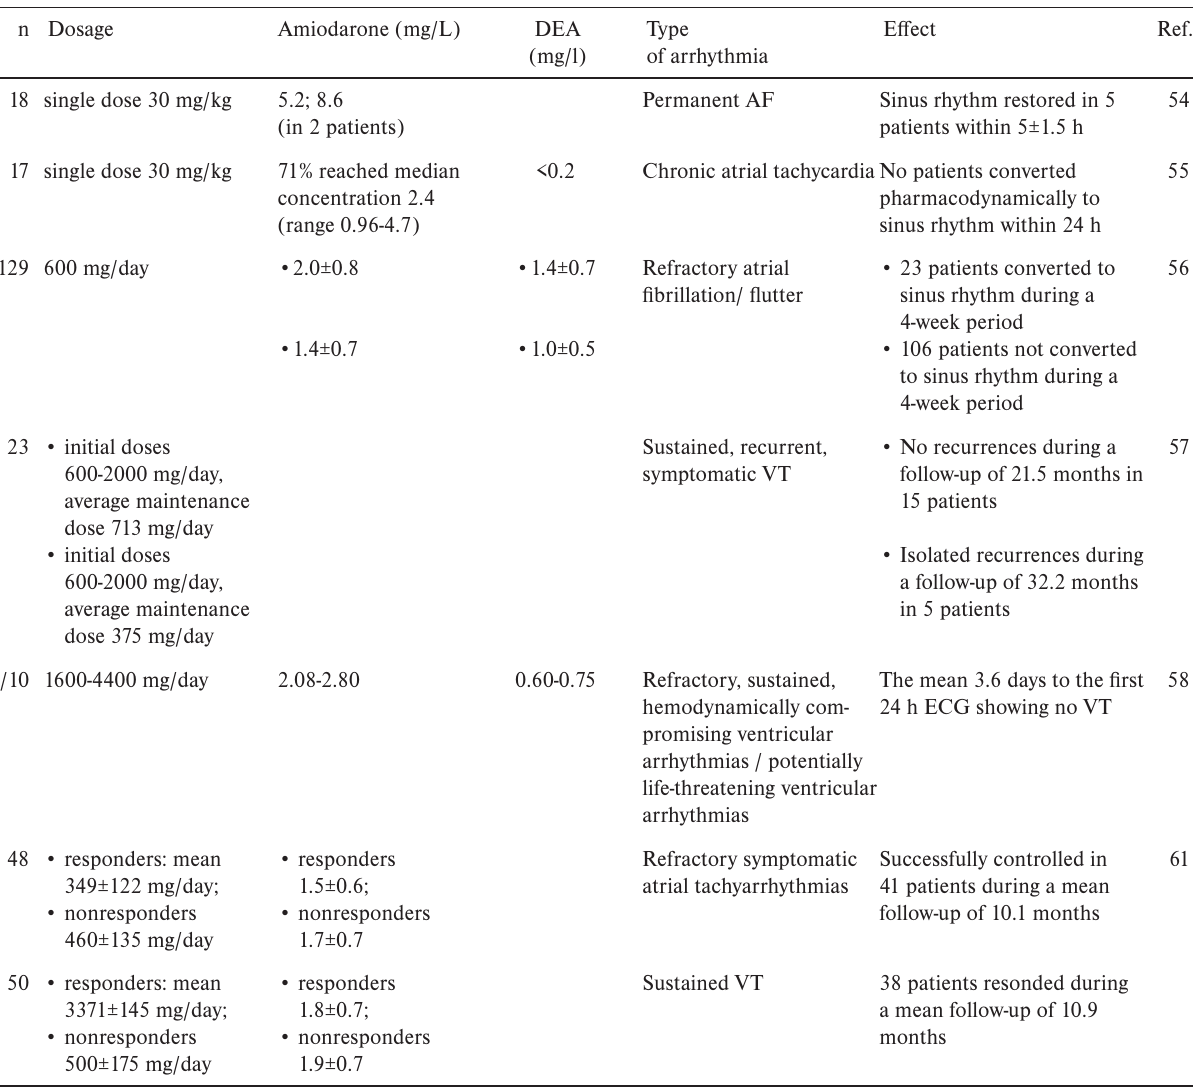
Table 3. Oral administration of